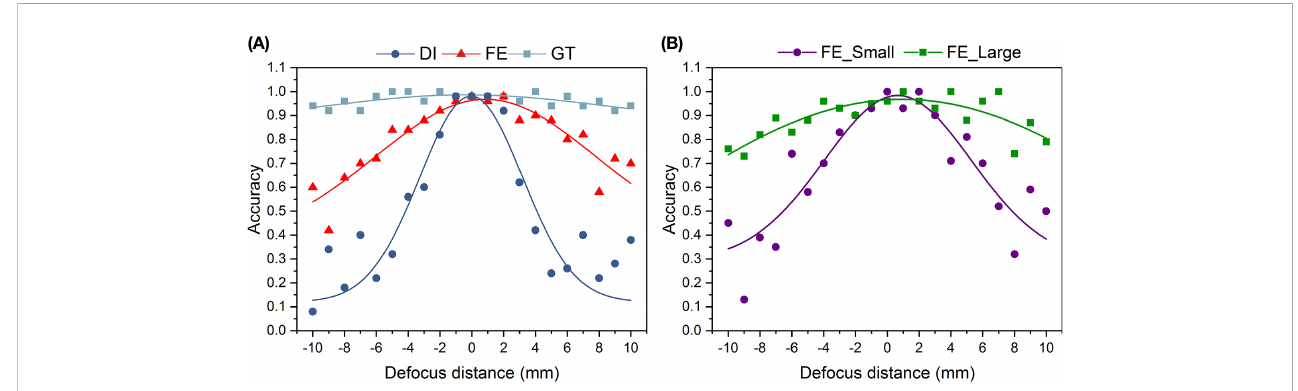
FIGURE 10 Performance comparison of a trained ResNet-18 deep network on classifying defocused plankton images, their focus-extended counterparts by IsPlanktonFE, and corresponding focused GT images. The ResNet-18 classi fi er has been trained on focused plankton images before this test. The value of each point is the average accuracy of 50 randomly selected testing plankton images. (A) plots the classi fi cation accuracy of the ResNet-18 model versus defocus distance on DI, FE, and GT testing plankton images. (B) further plots the classi fi cation accuracy on the FE plankton images grouped in two different sizes. FE_Small refers to plankton length (diagonal of ROI)<2mm. FE_Large refers to plankton length >2mm.